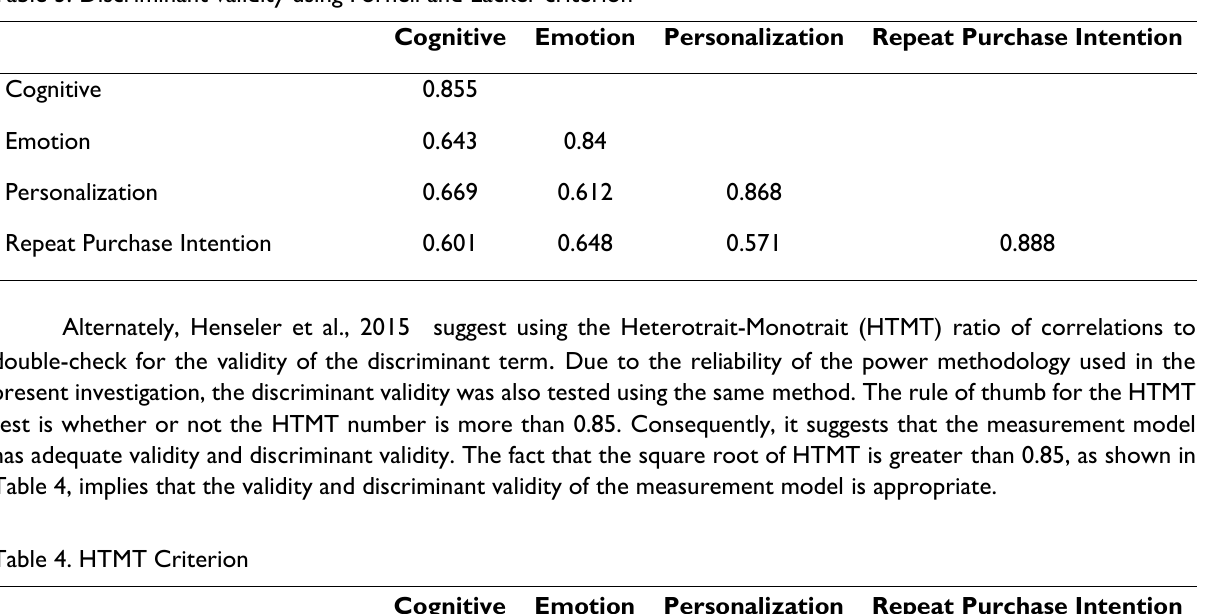
Table 3. Discriminant validity using Fornell and Lacker criterion